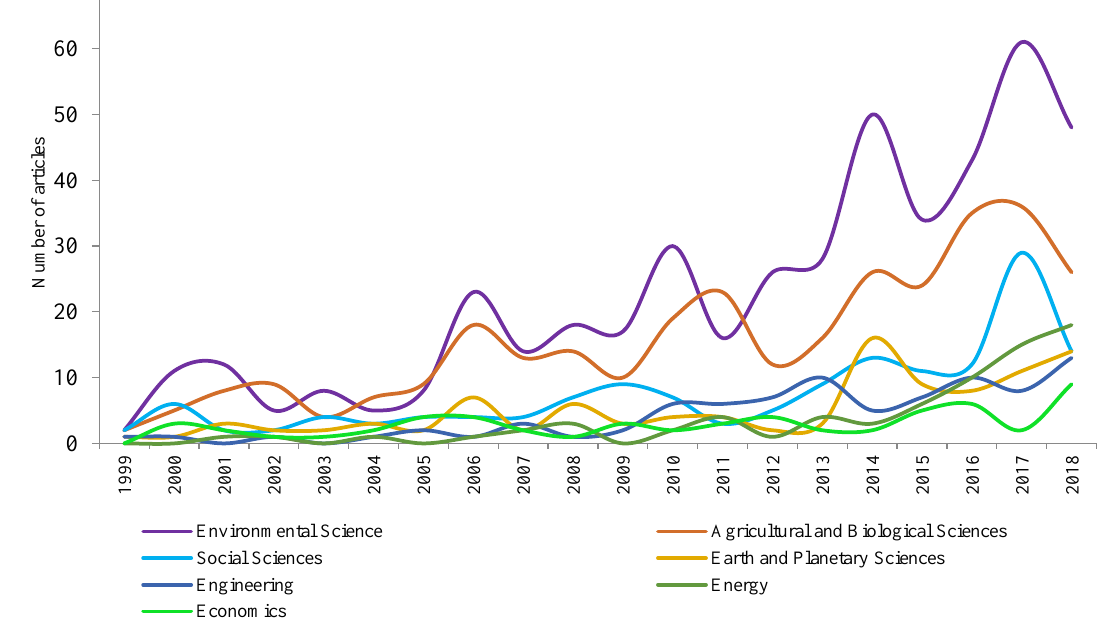
Figure 3. Comparative trends of subject categories related to SI research.